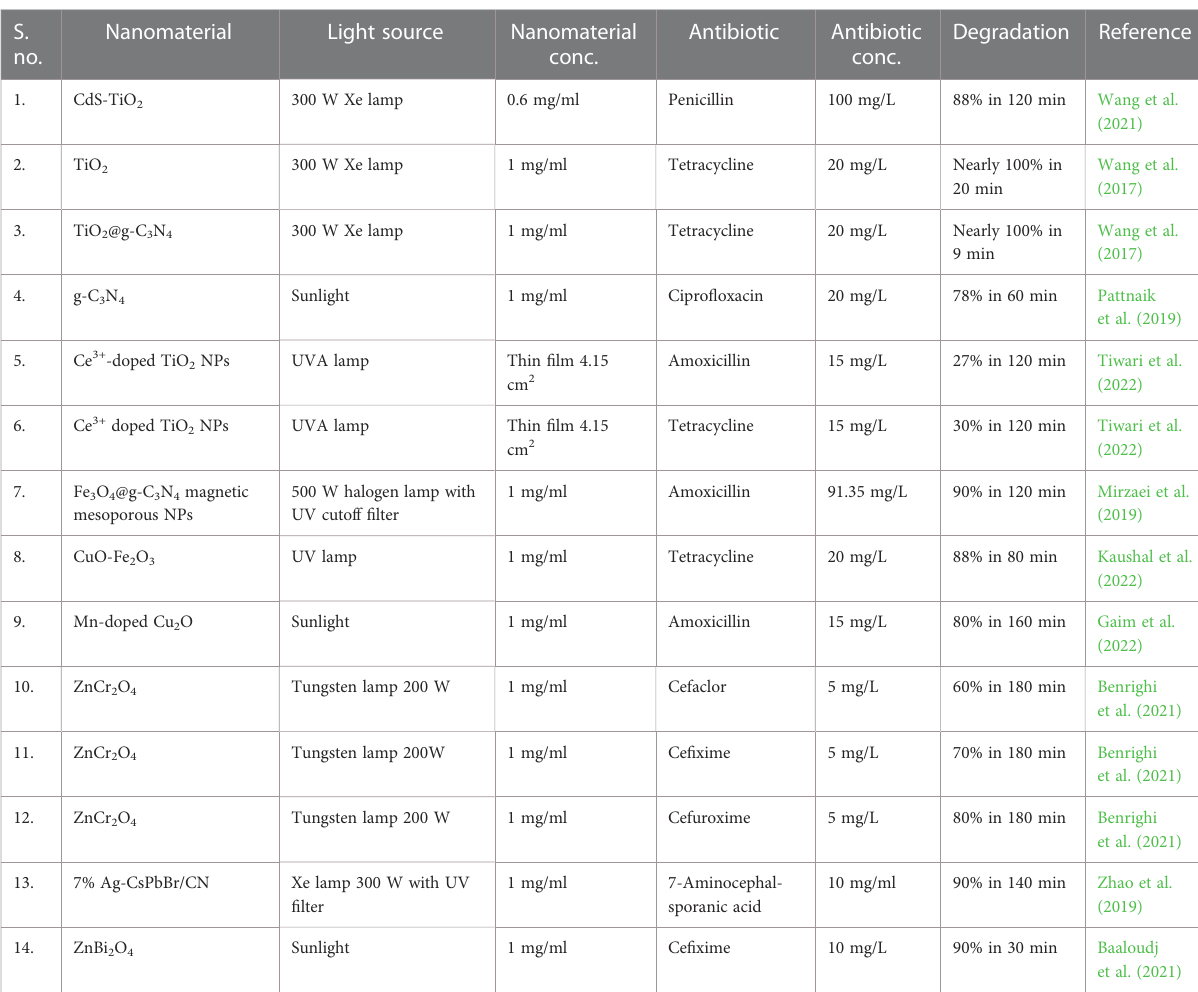
TABLE 3 Nanophotocatalytic degradation of select antibiotic classes.